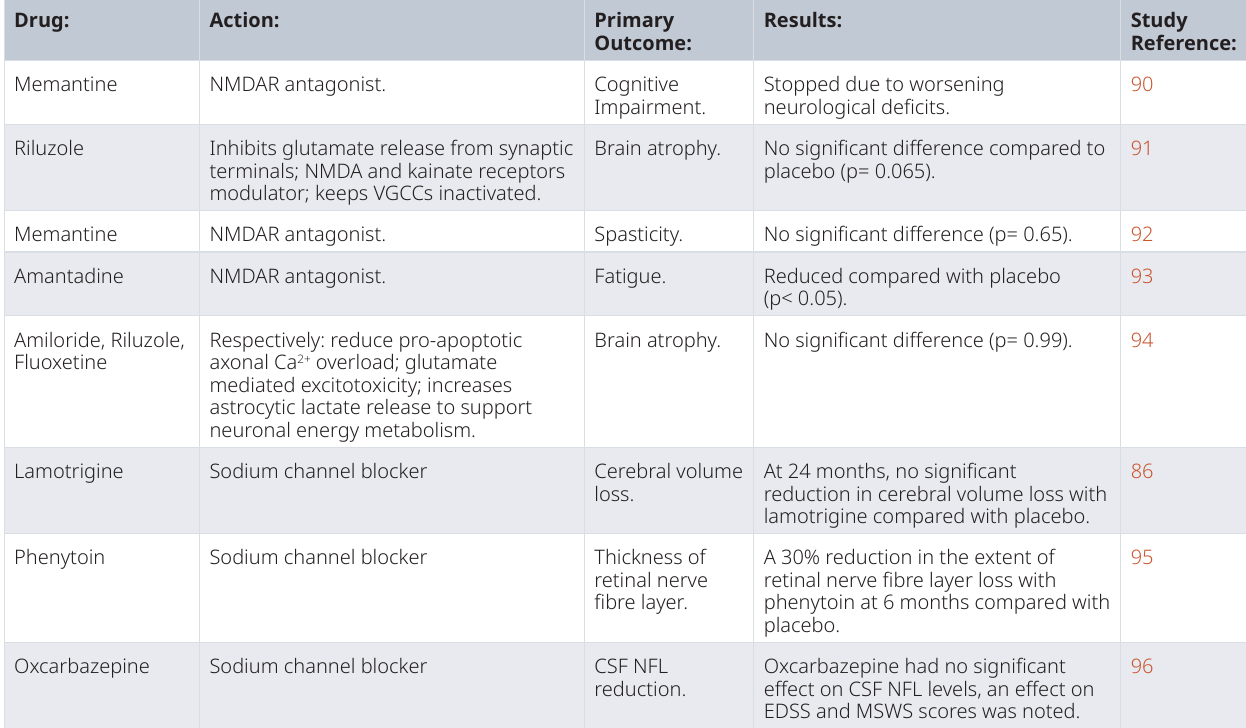
Table 2. List of completed clinical trials to lower excitotoxicity and investigate neuroprotection in MS.